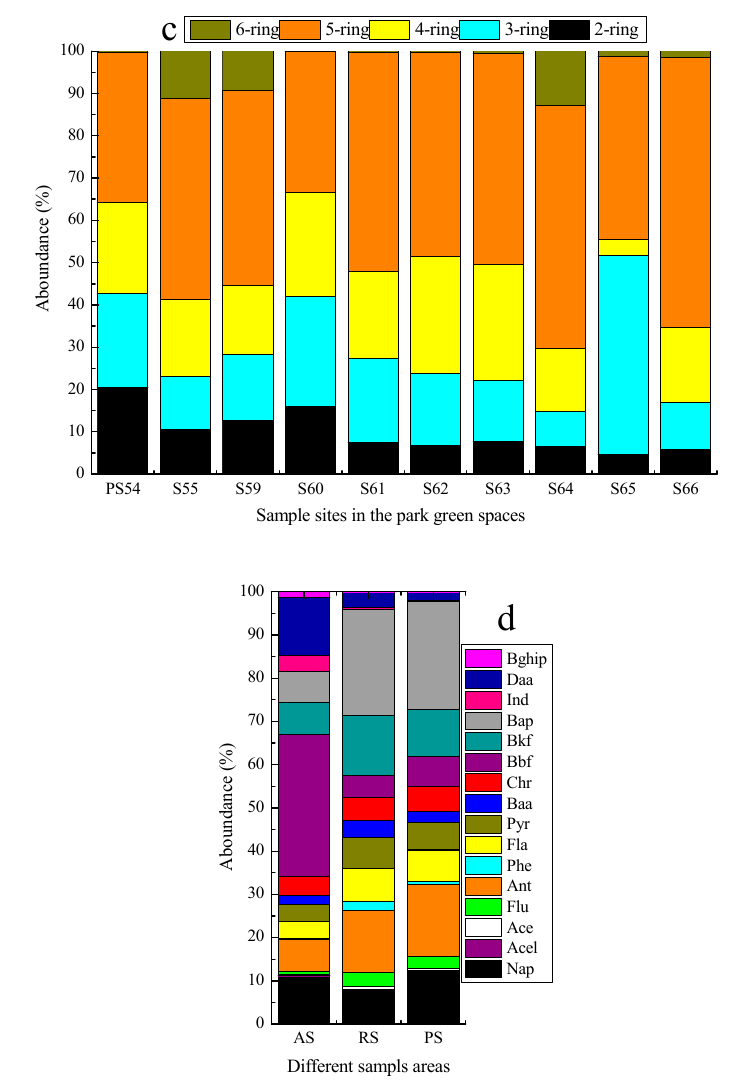
Figure 2. PAHs composition distribution in surface soils: ( a ) roadsides, ( b ) agriculture areas, ( c ) park green spaces, and ( d ) overall PAHcomponent distribution in all investigated samples. Notes: 2-ring (Nap); 3-ring (Ace, Acel, Flu, Phe, Ant); 4-ring (Fla, Pyr, Baa, Chr); 5-ring (Bbf, Bkf, Bap, Daa); 6-ring (Ind, Bghip).